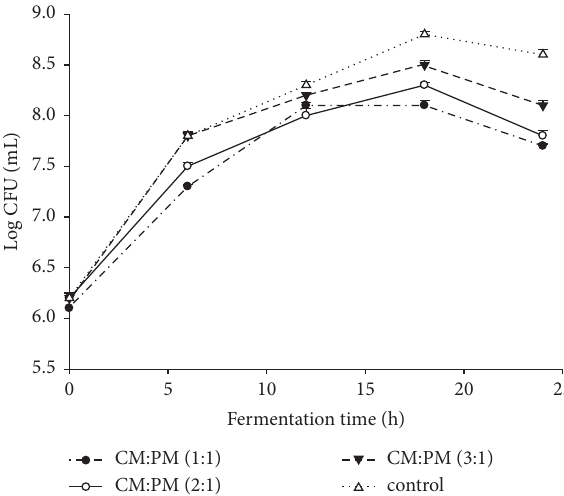
Figure 2: Titratable acidity values of four samples at different fermentation times. All the values are expressed as mean ± SD ( n � 3). CM, cowpea milk; PM, peanut milk.